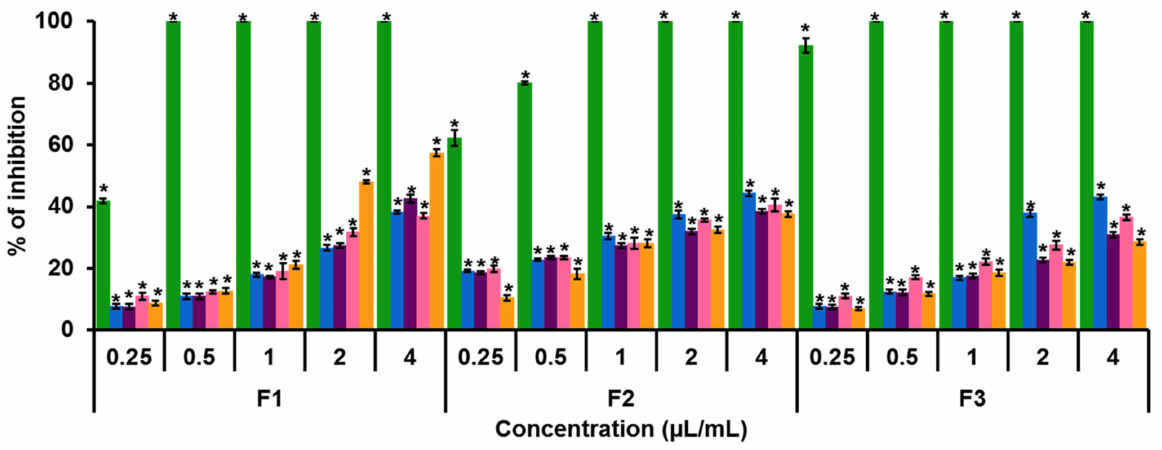
Figure 1. Effect of five pure compounds on the growth of three Fusarium strains. Percentage of growth inhibition in an in vitro model of Fusarium sporotrichioides (F1), Fusarium moniliforme (F2), and Fusarium solani (F3) exposed to carvacrol (green), p -cymene (blue), α -phellandrene (purple), α -pinene (pink), and Υ -terpinene (orange) at concentrations of 0.25, 0.50, 1.0, 2.0, and 4.0 µ L/mL. * Statistically significant values of mean with respect to the control ( p <